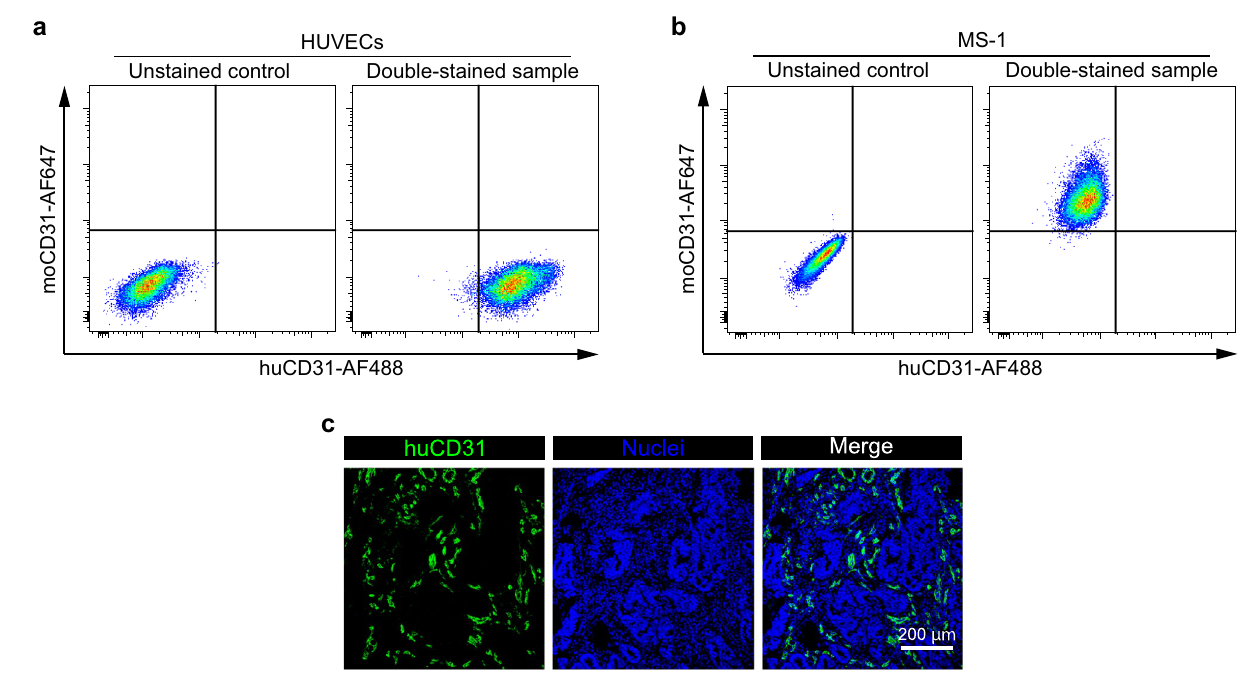
Figure 2. Determination of antibodies that specifically recognize human ECs. ( a ) Specificity of anti-CD31 antibodies for human ECs was analyzed by flow cytometry. Left panel shows unstained HUVECs (negative control) and right panel shows huCD31-AF488 Ab, moCD31-AF647 Ab double-stained HUVECs. ( b ) Specificity of anti-CD31 antibodies for mouse ECs (MS-1 cells) was analyzed by flow cytometry. Left panel shows unstained MS-1, and right panel shows huCD31-AF488 Ab, moCD31-AF647 Ab double-stained MS-1 cells. ( c ) Representative images of colorectal tumor tissues stained with huCD31-AF488 Ab (green). Nuclei (blue) were labeled with TO-PRO-3. Histograms and images are representative of three independent